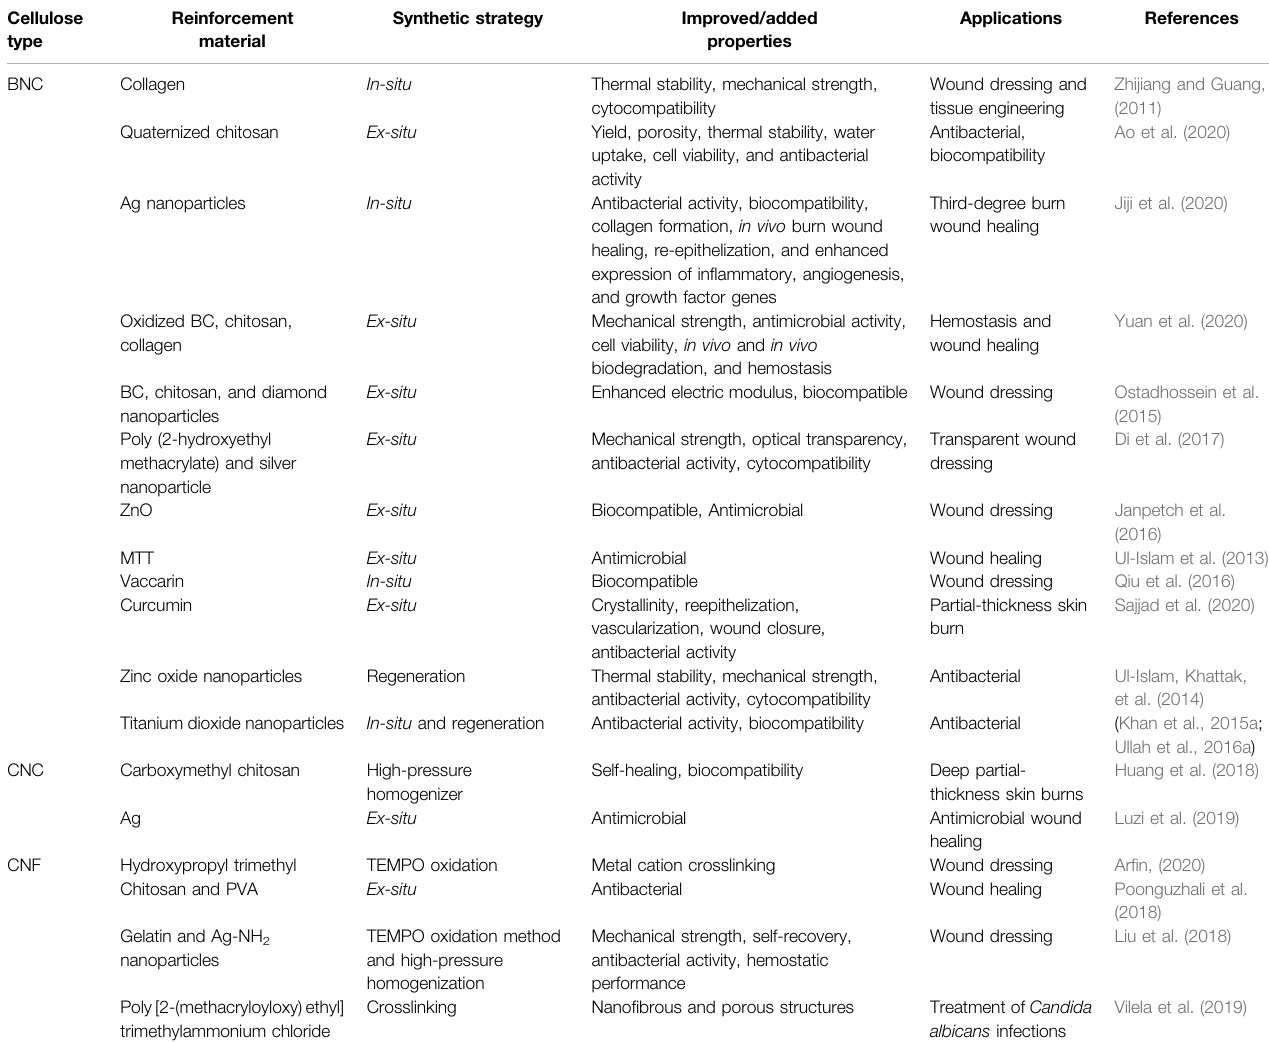
TABLE 3 | The improved properties and wound healing applications of different nanocellulose-based